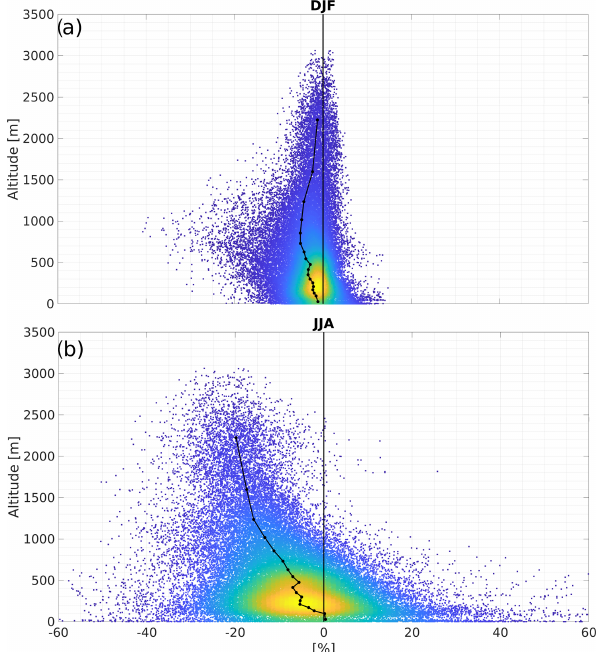
Figure 5. Relative variation in the mean seasonal precipitation as a function of surface elevation in DJF (a) and in JJA (b) . The black line indicates the mean relative variation in 18 classes based on grid cell surface elevation, defined to have the same number of data in each class. Colors represent the density of the points in the GAR (yellow: high density; blue: low